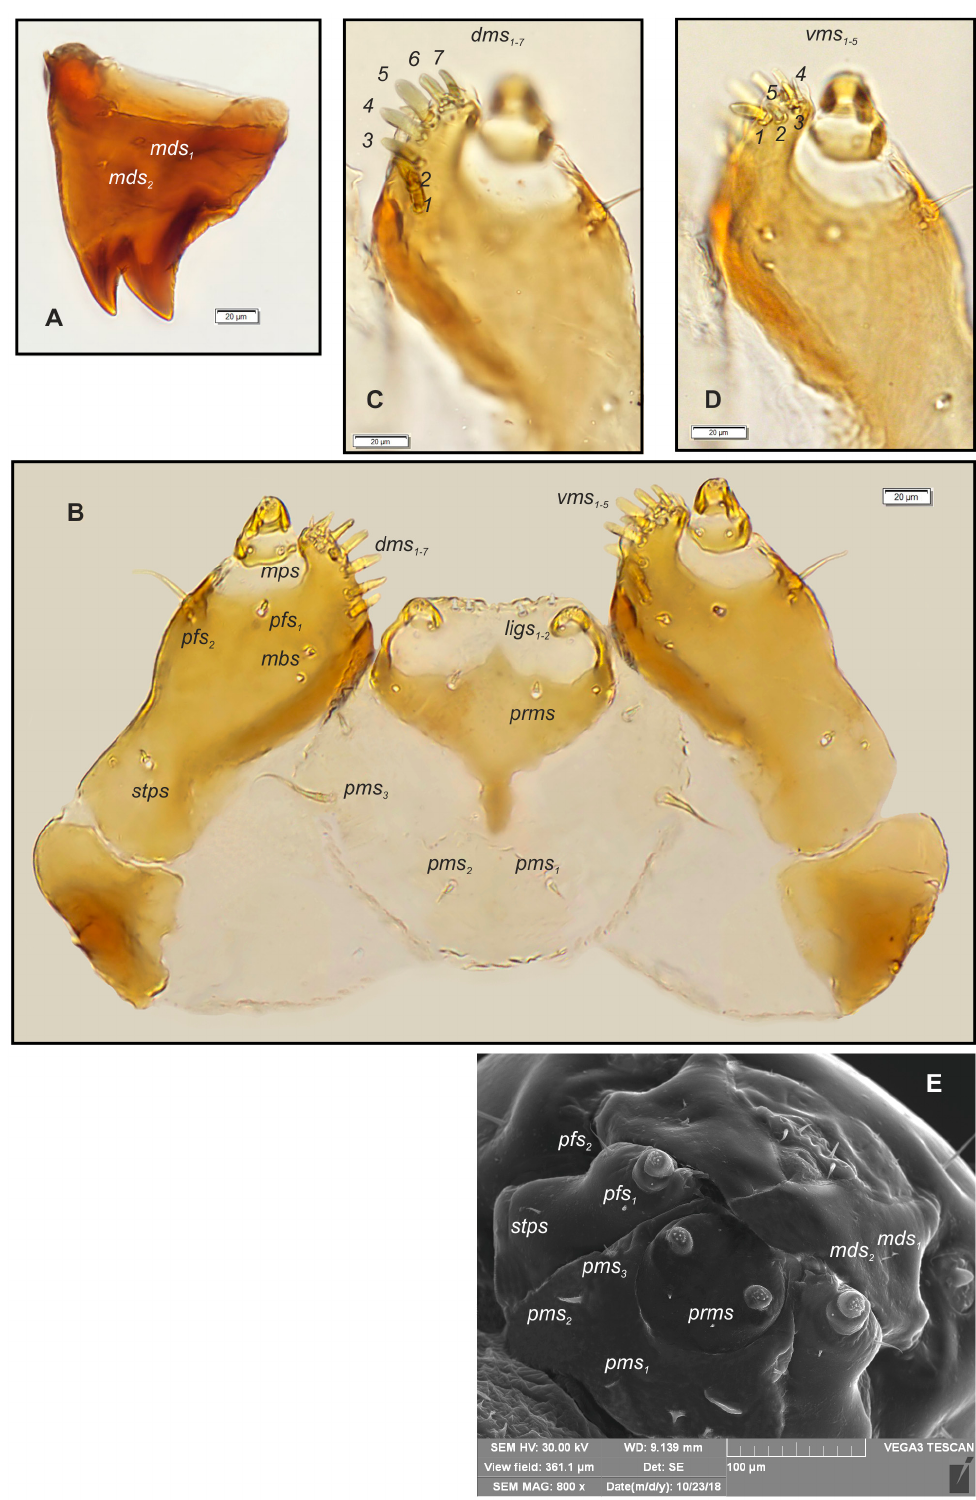
Figure 5. Bagous claudicans mature larva, mouthparts. A —right mandible; B —maxillolabial complex, ventral view; C —apical part of right maxilla, dorsal view; D —apical part of right maxilla, ventral view; E —mandibles and maxillolabial complex, SEM photography (setae: dms —dorsal malar, ligs — ligular, mbs —malar basiventral, mds —mandibular, mps —maxillary palp, pfs —palpiferal, prms — prelabial, pms —postlabial, stps —stipal, vms —ventral malar).